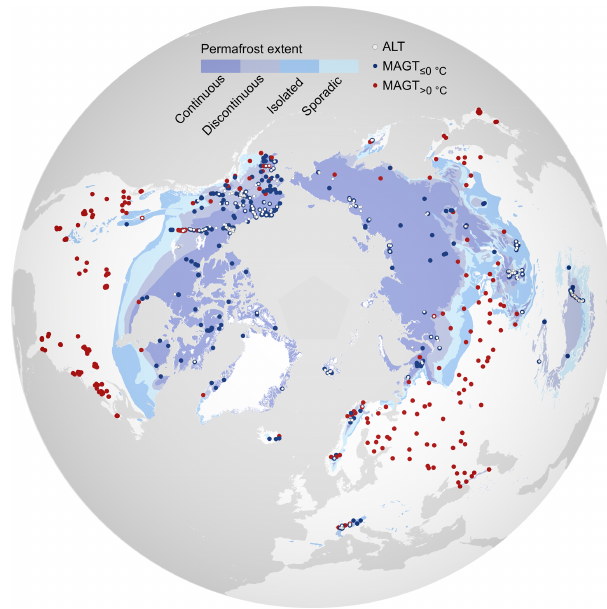
Figure 1. The observational network of the mean annual ground temperature (MAGT) and active-layer thickness (ALT) measure- ment sites across the Northern Hemisphere that were used in this study. Blue symbols indicate the locations of boreholes where MAGT (averaged over the period 2000–2014) was at or below 0 ◦ C and red symbols indicate those above 0 ◦ C. White symbols depict the ALT measurement sites. The underlying permafrost zonation is from Brown et al.